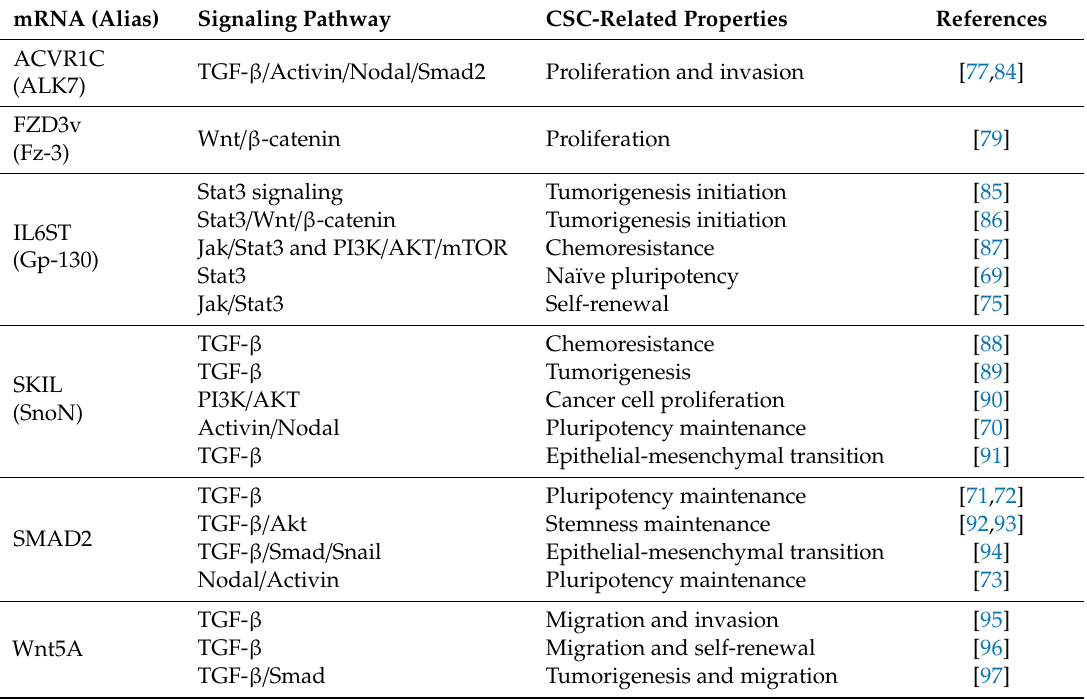
Involvement of the core mRNA in CSC-related properties and the implicated signaling